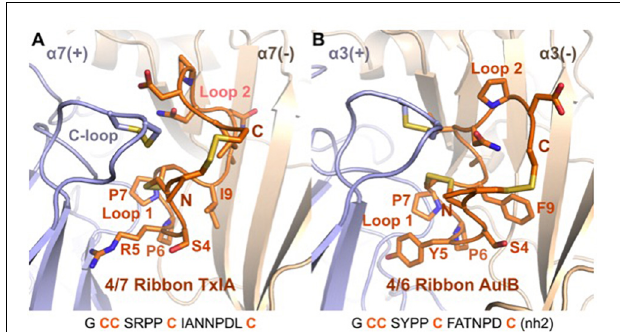
FIGURE 7 | Comparison of the binding mode of ribbon TxIA (A) and ribbon AuIB (B) at the interface between two α 7 or α 3 subunits, respectively. The toxins are in orange, with their backbone in cartoon representation and their side chains in stick representation. The binding site principal (+) and complementary (–) subunits are shown in blue and wheat color, respectively. The vicinal disulfide bond of the C-loop is shown in stick representation. The two binding sites have been oriented similarly for convenient comparison. The sequence of the two toxins is shown at the bottom of the figure.